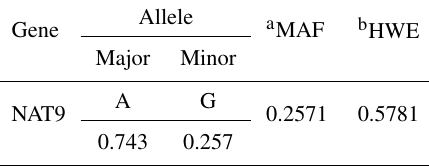
Table 2. Allele frequency of the SNP in